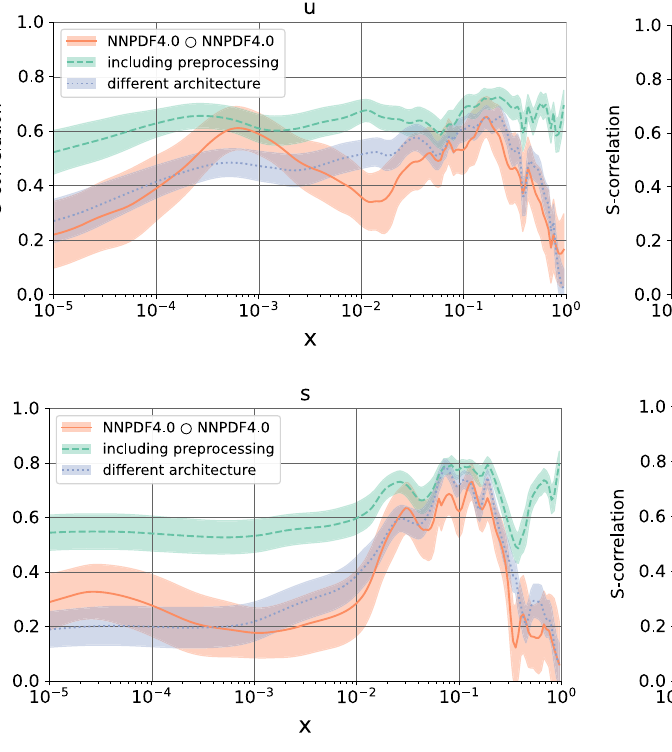
Fig. 5 The data-driven component of the S-correlation Eq. (12) between PDFs determined with the NNPDF4.0 methodology (same as Fig. 4) compared to the case in which also the preprocessing-induced component is included in the correlation (green), and the case in which